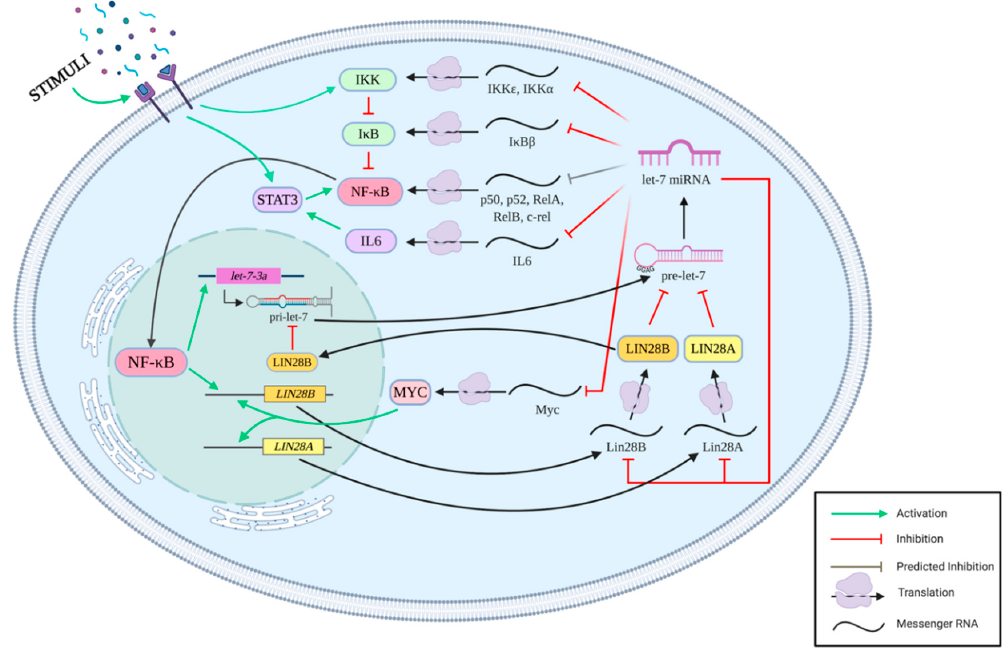
Figure 1. Diagram highlighting prominent pre- and post-transcriptional interactions between NF- κ B and the Lin28/let-7 pathways. Core components of the NF- κ B activation pathway are impacted by let- 7 miRNA levels [83,97–99,107,121,122], and the Lin28/let-7 regulatory loops are governed by NF- κ B-dependent gene expression [83,84,95,96,118–120]. Figure created with